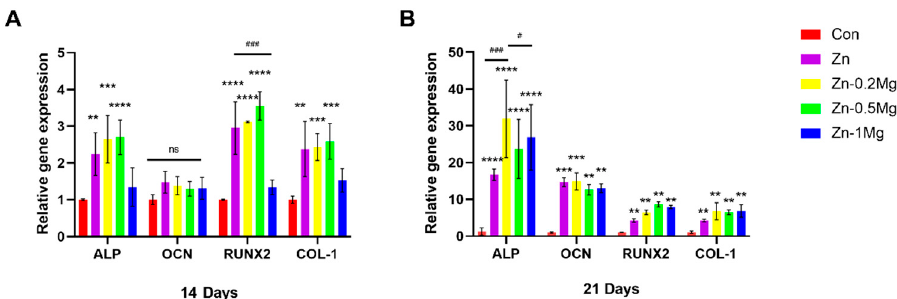
Figure 5. Expression of genes related to osteogenesis. Gene expression results for MC3T3-E1 at ( A ) 14 days and ( B ) 21 days. Compared with the control group, **** p < 0.0001, *** p < 0.001 and ** p < 0.01; compared with the Zn group, ### p < 0.001 and # p < 0.05; (ns) indicates no statistical signifi- cance.